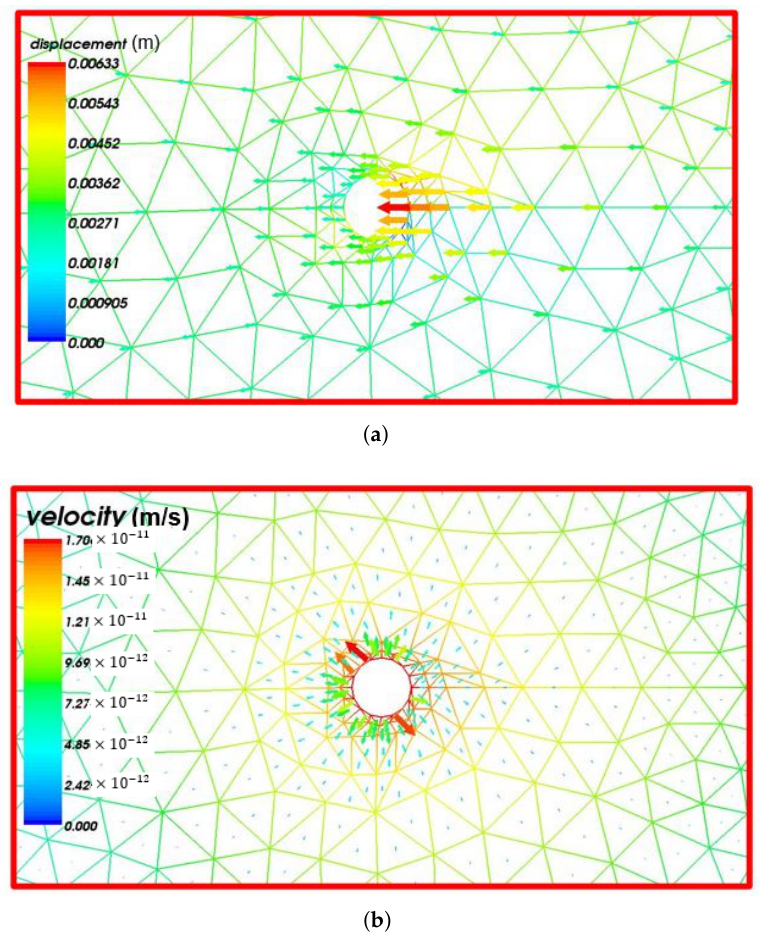
Figure 16. CSMP++ 2D steady-state chemo-thermo-poroelasticity ( a ) rock displacement (m) and ( b ) pore-fluid velocity (m/s) close-up around the 2D